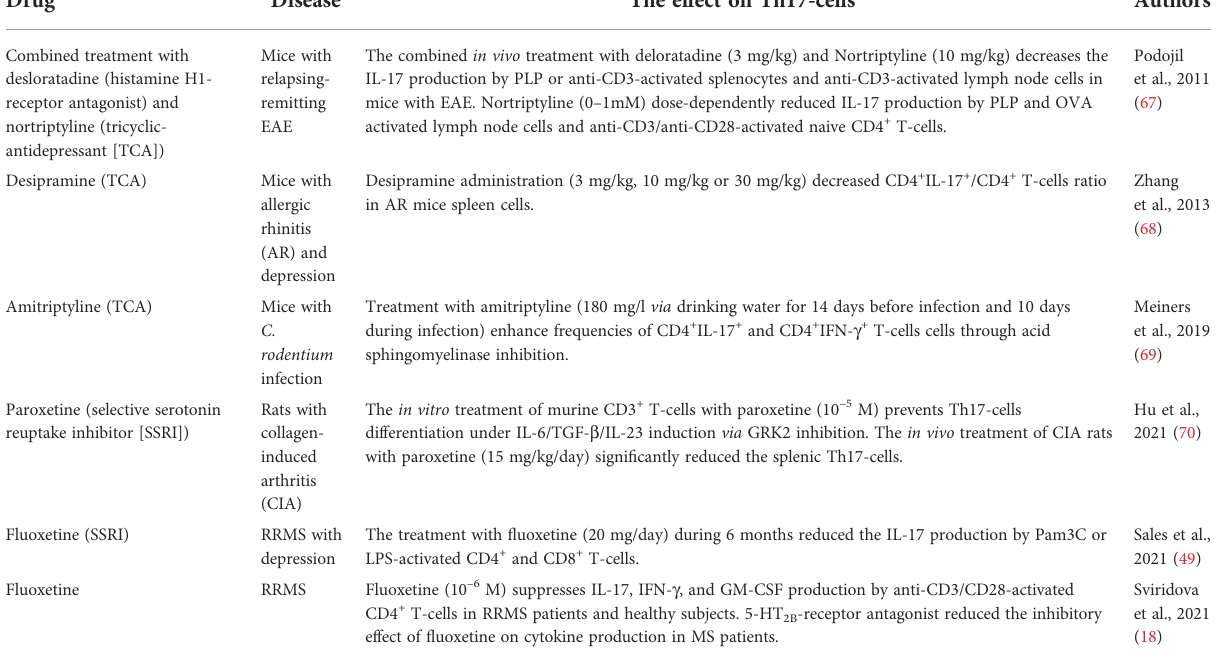
TABLE 1 The in fl uence of antidepressants on Th17-cells function. Drug Disease The effect on